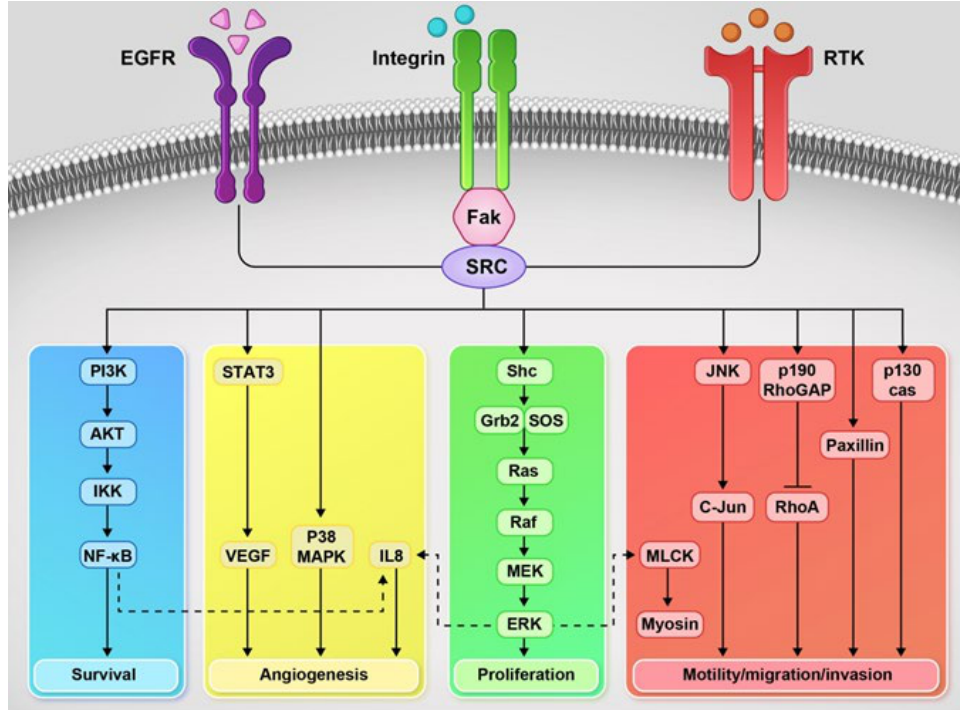
Figure 2. Src signaling. FAK, focal adhesion kinase; RTK, receptor Tyr kinase; PI3K, phosphatidyli- nositol 3-kinase; Akt, PKB; IKK, IkappaB kinase; NF- κ B, nuclear factor kappa light chain